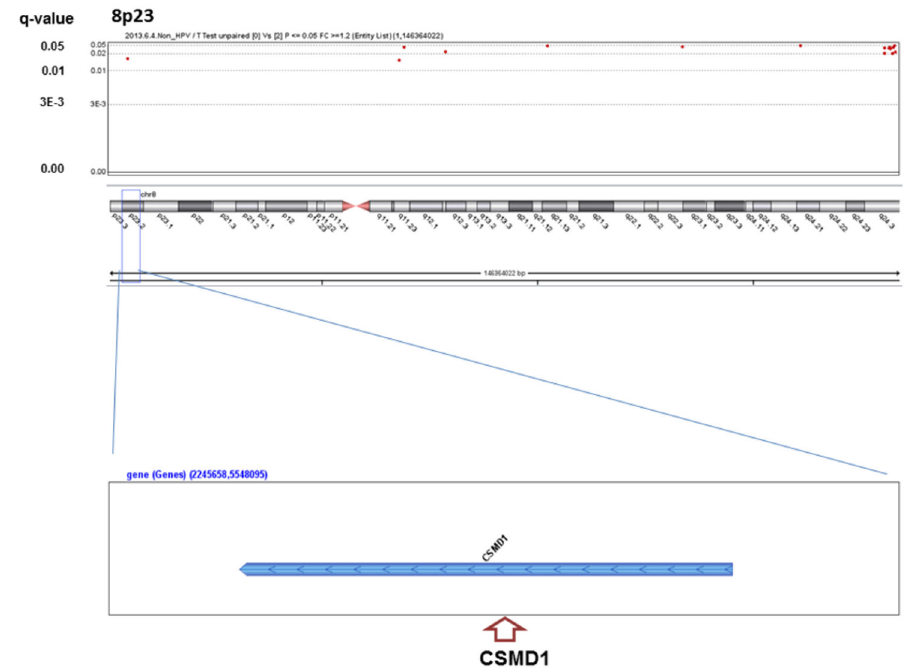
Figure 5. Significant SCNAs at 8p23 associated with heavy alcohol consumption.